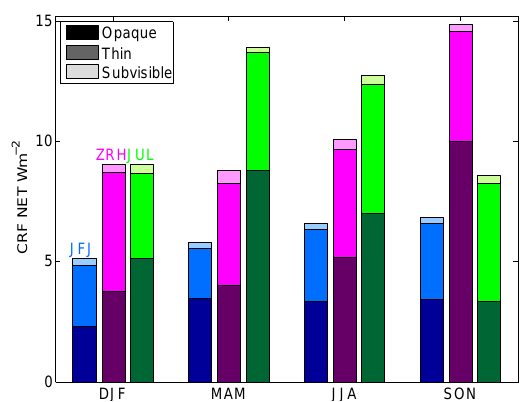
Figure 9. Cirrus radiative forcing under cloudy conditions, CRF NET (overcast), for the different seasons on Jungfraujoch (blue), in Zürich (pink), and in Jülich (green). Light shading: subvisible cir- rus ( τ < 0 . 03). Medium shading: thin cirrus (0 . 03 < τ < 0 . 3). Dark shading: opaque cirrus (0 . 3 < τ